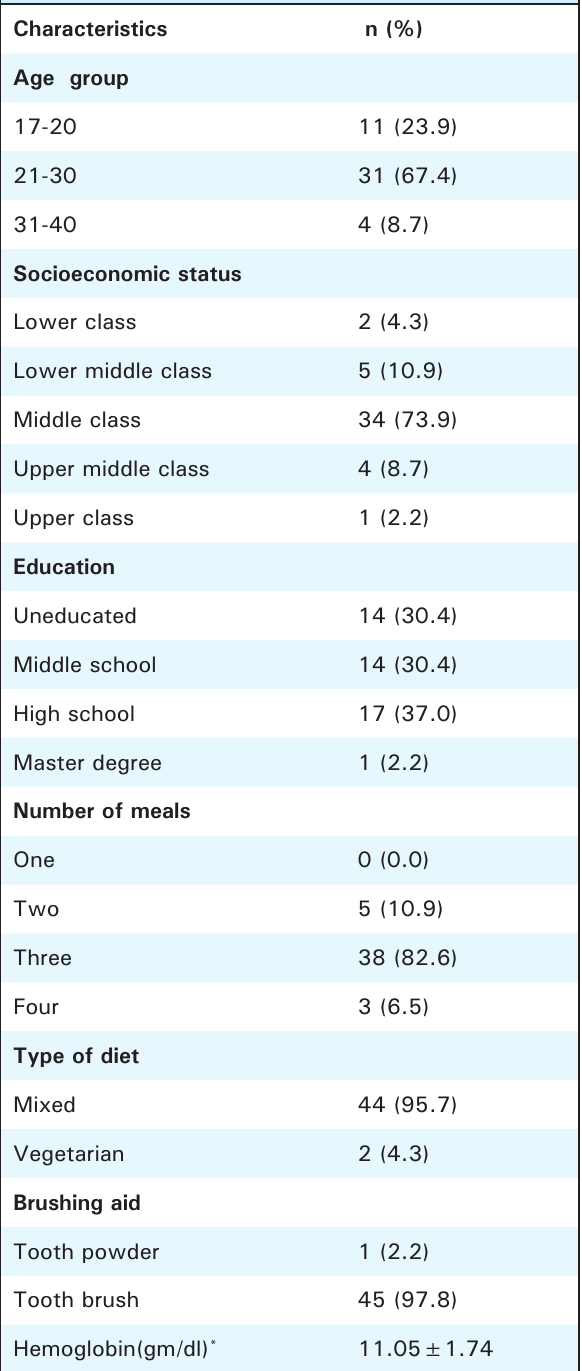
Table 1. Description of the general characteristics of pregnant women.